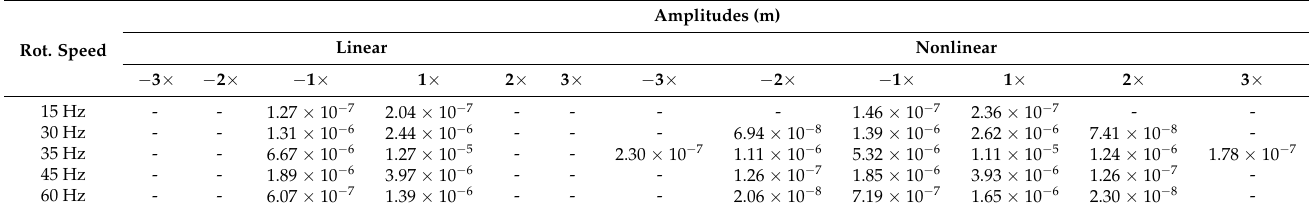
Table 1. Magnitudes of the most relevant peaks of Figure 9—elliptical bearing (preload 0.25).